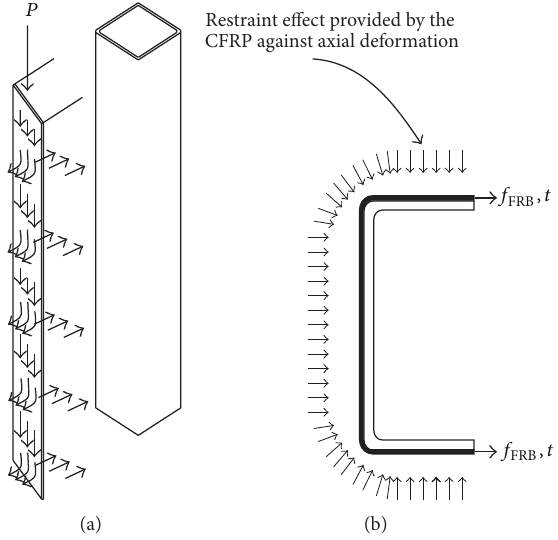
Figure 11: (a) Membrane strain in steel tube and (b) restraint effect by